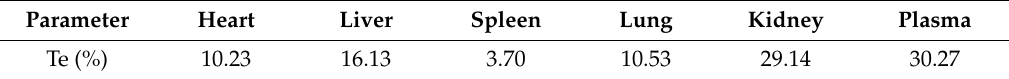
Table 6. Targeting parameters (Te) of GA-S in mice tissues and plasma. Parameter